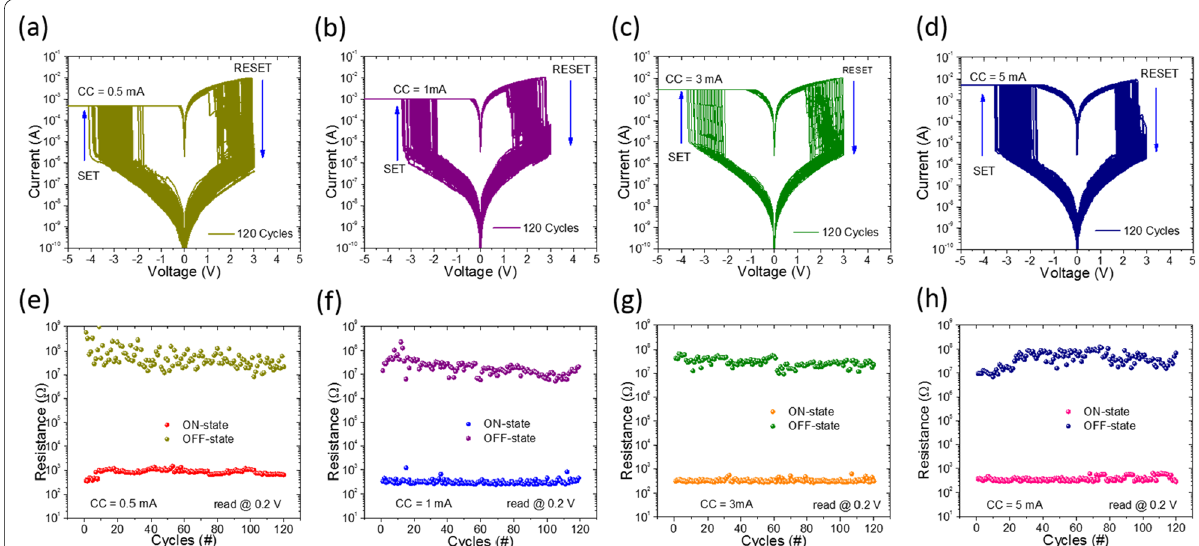
Fig. 3 a – d Typical bipolar I–V curves, and e – h endurance performance of Pt/HfO 2 /Al 2 O 3 /TaN memristive devices at different current compliances of 0.5 mA, 1 mA, 3 mA, and 5